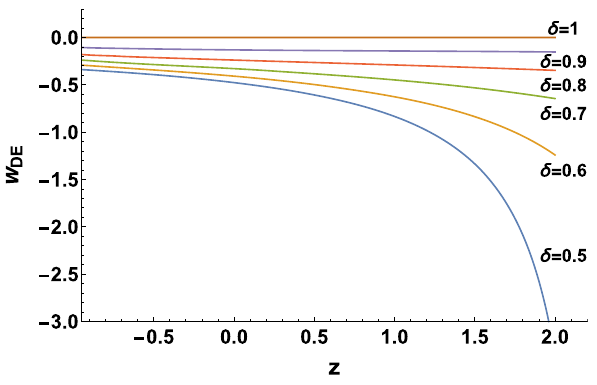
Fig. 3 The evolution of the equation-of-state parameter w DE as a function of the redshift z , for (cid:3) = 0 and for various values of the nonextensive parameter δ , in the case where radiation is present. For each value of δ we choose α according to (53) in order to obtain (cid:4) ( z = 0 ) = (cid:4) = 0 . 3 and (cid:4) ( z = 0 ) = (cid:4) = 0 . 000092 m m 0 r r 0